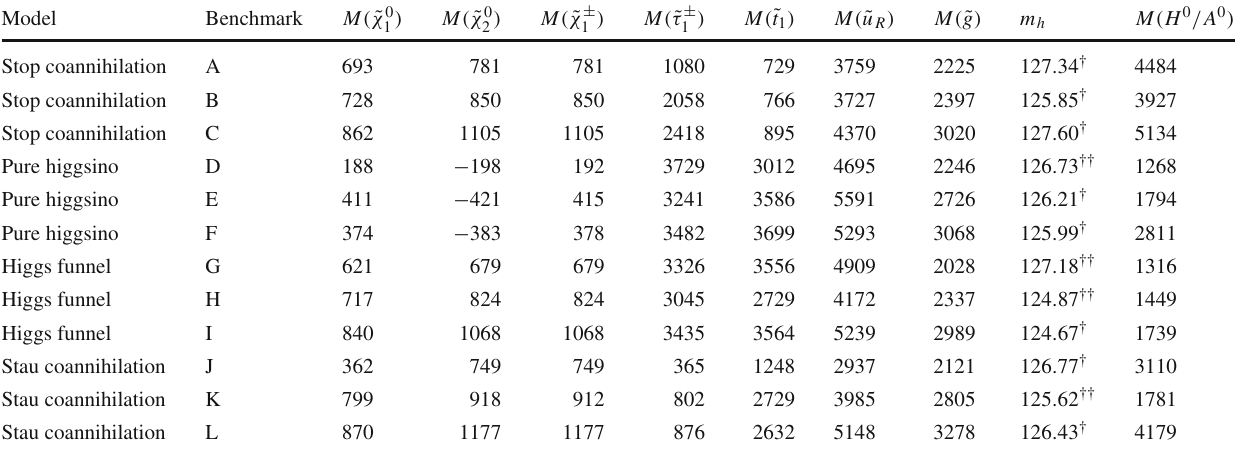
Table 2 Relevant SUSY spectrum masses for the F - SU ( 5 ) general SUSY breaking soft terms of Table 1. The soft SUSY breaking terms that generate each of these spectra can be identified by the alphabetical label. A † symbol in the light Higgs boson mass m h column represents the theoretically computed value consisting of only the 1-loop and 2-